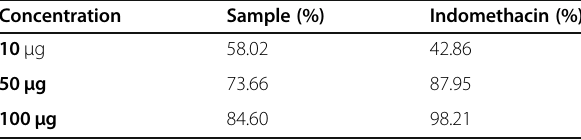
Table 3 Percentage inhibition of hyaluronidase enzyme